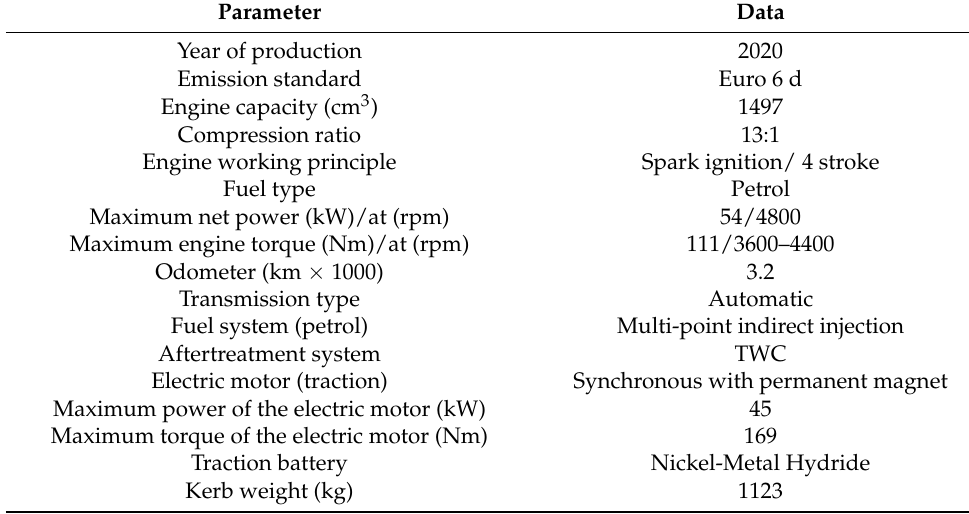
Table 1. Technical data of the tested vehicle.